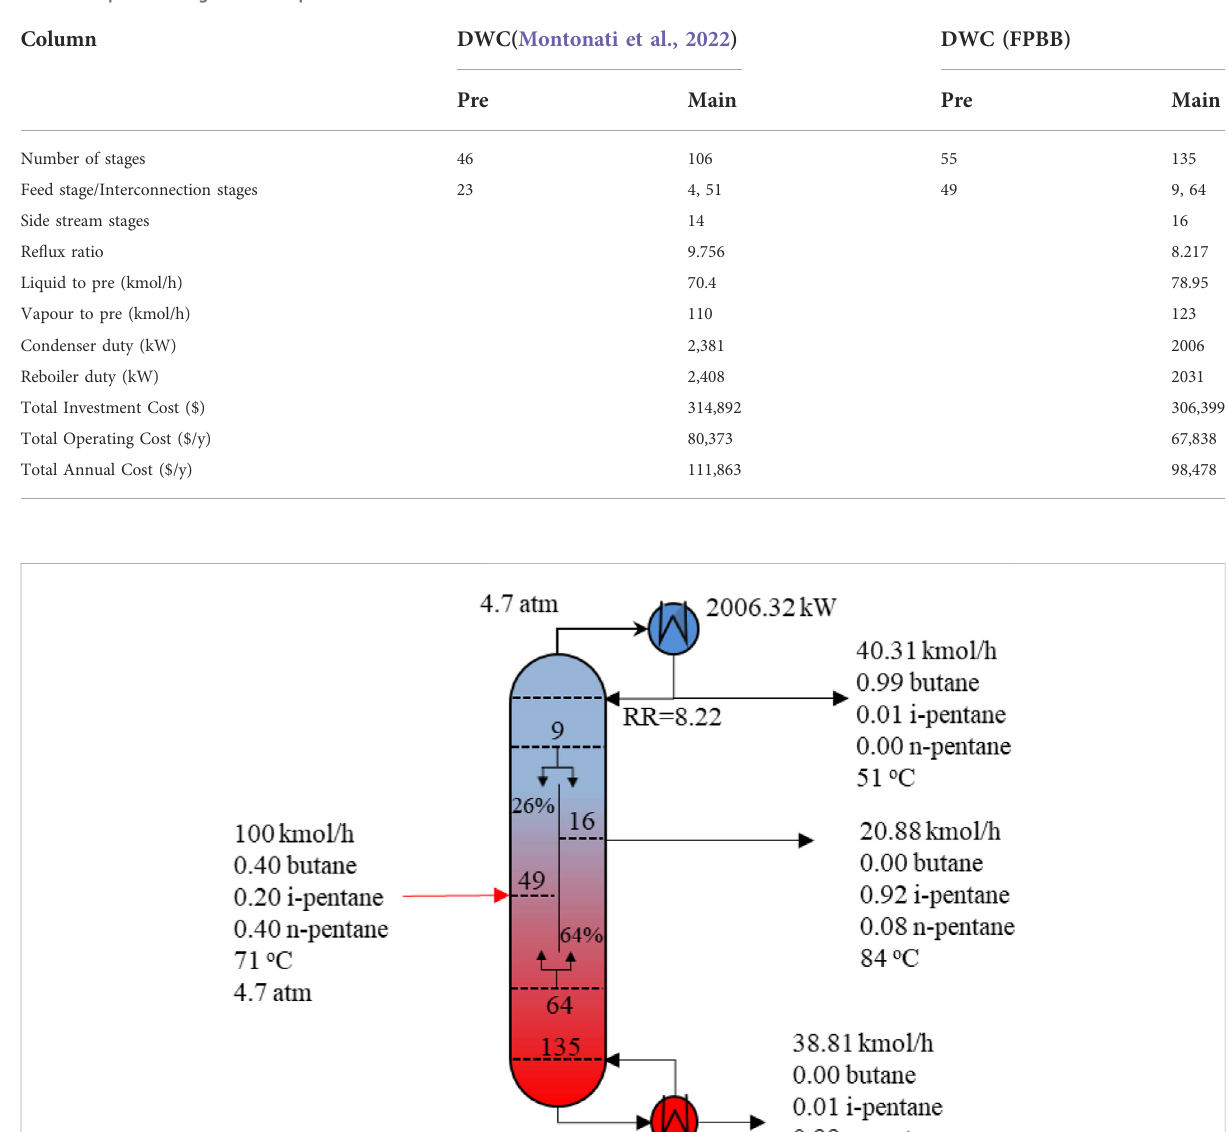
TABLE 5 Optimal design for Example 2.